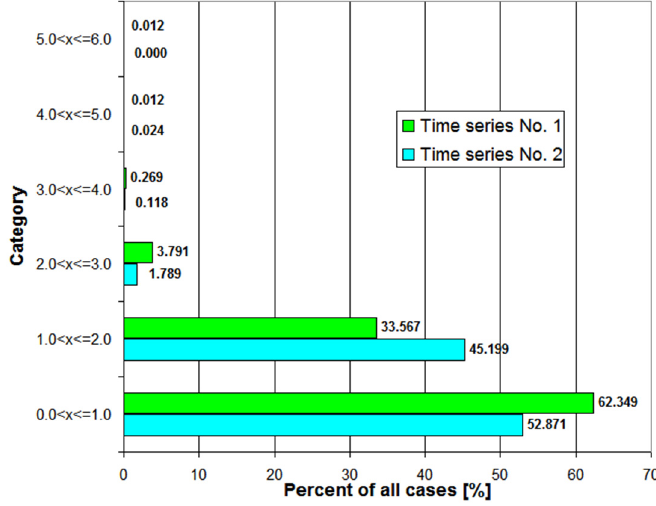
Figure 1. Percentage distribution of cases in both time series depending on the power demand value.